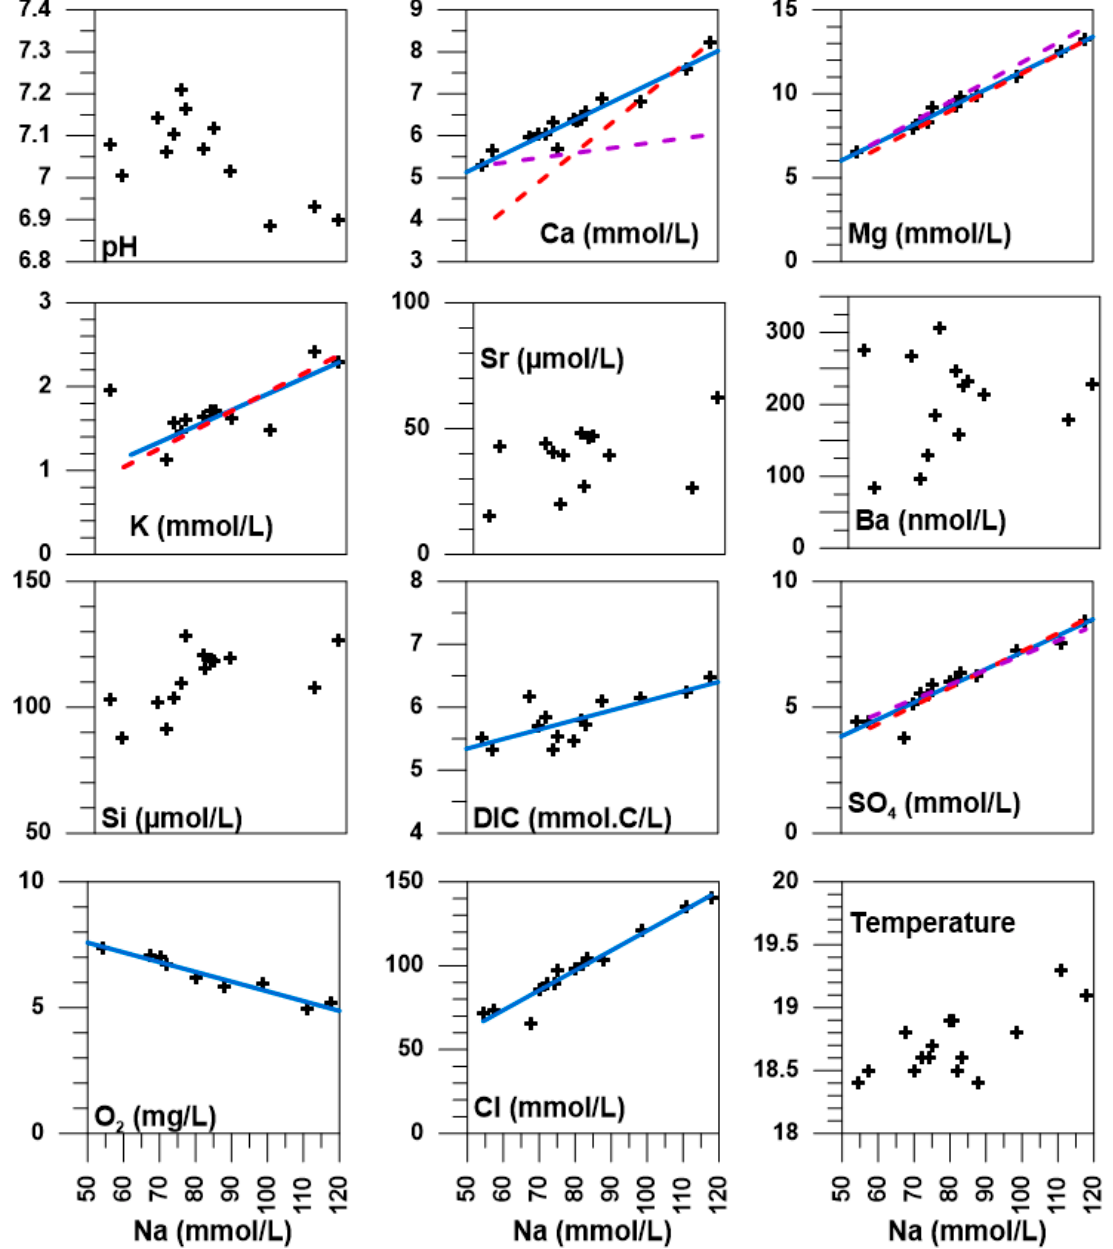
Figure 4. Parameters measured in situ (salinity, pH, temperature, dissolved oxygen) and element concentrations versus the Na content of the karstic spring waters. The blue solid lines are linear fits to the data meant to outline the trends. The red dashed lines are calculated for the case where the highest salinity spring water (salinity 9.4) is diluted by freshwater infiltration. The purple dashed lines represent the variation of the element concentrations when modern seawater (salinity 38 for the Mediterranean Sea) contaminates the spring water with the lowest salinity (salinity 4.7).